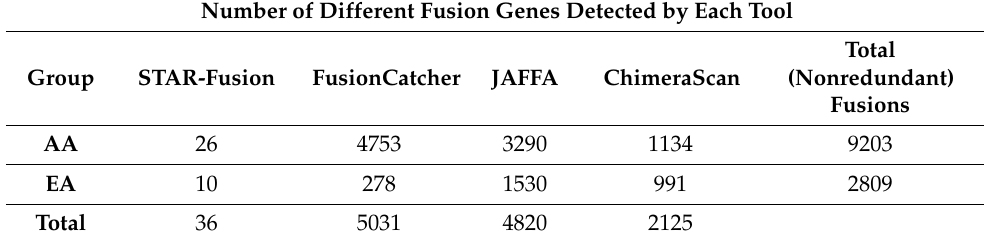
Table 4. Comparison of fusion genes predicted by the four detection tools. (Low-confidence fusions detected by JAFFA were excluded from this comparison).